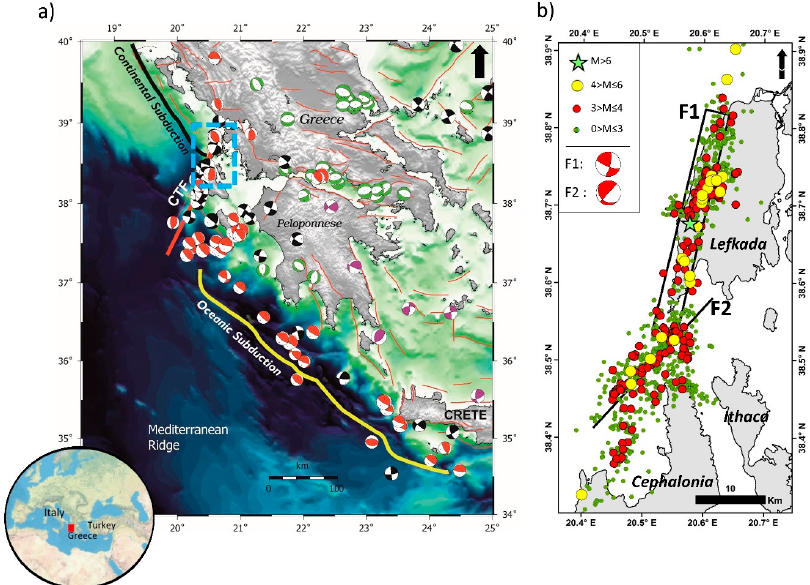
Figure 1. ( a ) Tectonic setting in the western Hellenic Subduction Zone, depicting the two different subduction regimes, which are offset (~100 km) by the operation of the Cephalonia Transform Fault Zone (CTF). Beach balls denote focal mechanisms of M > 5.5 earthquakes, and the magenta colors denote focal depths > 50 km. Black beach balls = strike-slip faulting, red = thrust/reverse faulting, and green = normal faulting. The dashed blue rectangle indicates the area of this study. The red rectangle in the lower left inset globe map is the locus of interest. ( b ) Map showing the Lefkada 2015 relocated seismic sequence (location data are from [21]) and our proposed fault segmentation (F1 and F2) for the Cephalonia – Lefkada Transform Fault zone. This complexity is also reflected in the modelling of geodetic data. For example, Ganas et al. [10], based on InSAR and Global Positioning System (GPS ) data, presented two uniform slip fault models; one with a unique fault and another one with two faults. Their preferred solution is the two-fault uniform slip model, which comprises of the main fault alongside a smaller fault, parallel to the main one, located partly onshore the island of Lefkada, close to the latitude of the mainshock. Bie et al. [8] used Sentinel-1 imagery as input and performed a series of tests to identify the slip distribution. They show three slip patches in their preferred slip distribution. The southern patch is related with the